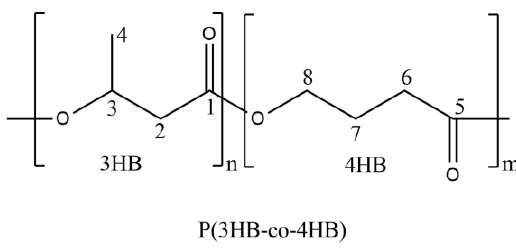
Figure 1. Chemical structure of P(3HB- co -4HB).